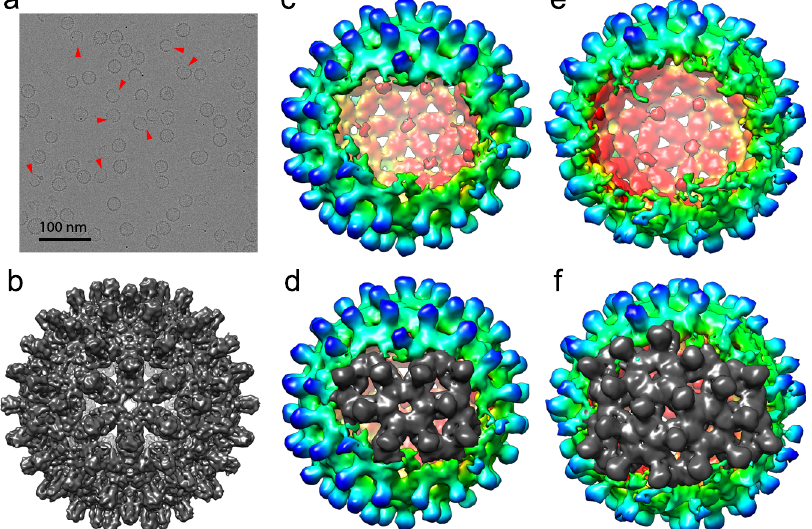
Fig. 5 Cryo-EM characterization of holey capsids. a A cryo-EM micrograph of a holey capsid sample. Several obvious holey capsids are pointed out by red arrows. b , c , e Reconstructions yielded a 120-dimer complete capsid (EMD-22132) ( b ) and two species of holey capsids ( c EMD-22134 and e EMD-22135). d , f Comparing holey to complete capsid maps shows that the capsid with the small hole ( c , d ) is missing density for nine dimers including one hexamer. Whereas the capsid with a bigger hole ( e , f ) is missing density for ~18 dimers including two hexamers and a pentamer. The partial subunits at the periphery of the holes suggests heterogeneity of hole size and mobility of peripheral dimers. For these fi gures, capsid density is contoured at 1.3 σ . Holey capsids are colored by radius for contrast (blue 35 nm, green 32 nm, red 29 Fig. 4b, we found that EDTA and urea reduced the proportion of 120-dimer T = 4 capsids, had little effect on the proportion of 90-dimer T = 3 particles, and introduced a new heterogeneous mixture of incomplete, stable capsids (Fig. 4b, green line). The remaining T = 4 and T = 3 capsids appear to be intact and may be assembled exclusively from Cp150 homodimers.